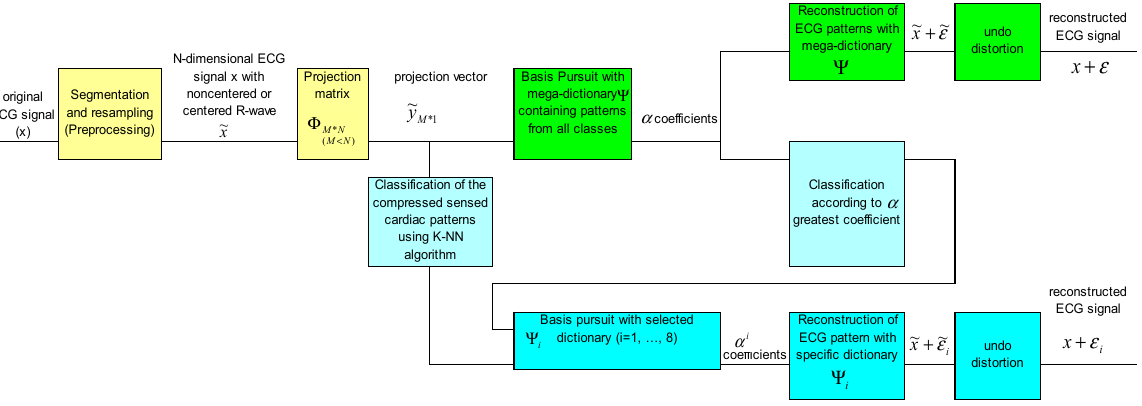
Figure 3. Block diagram of the CSCP method, using the mega-dictionary and/or a pathology-specific dictionary.